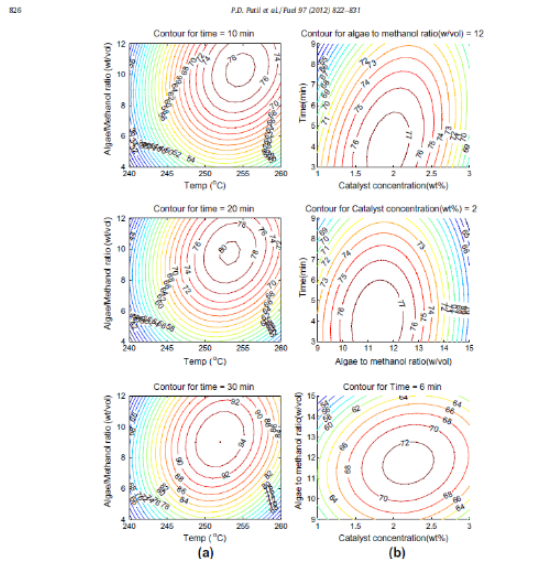
Figure 5. Effect of algae to methanol ratio (wt./vol.), catalyst con- centration (wt.%), and reaction time (min) on the fatty acid methyl ester (FAME) content using RSM in MW